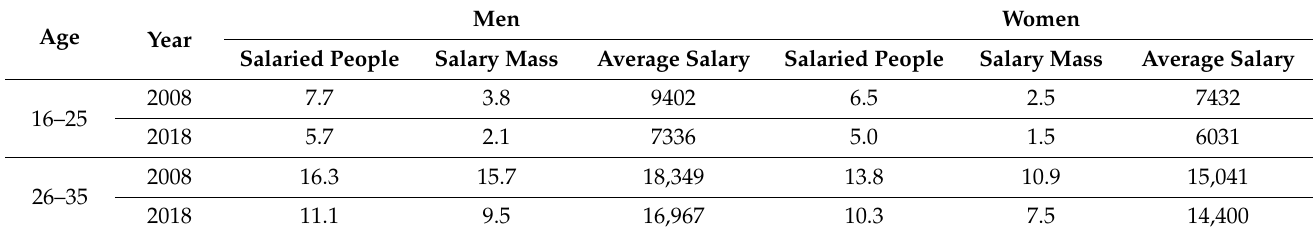
Table 2. Salaried people, total earnings, and average salary by gender, Spain